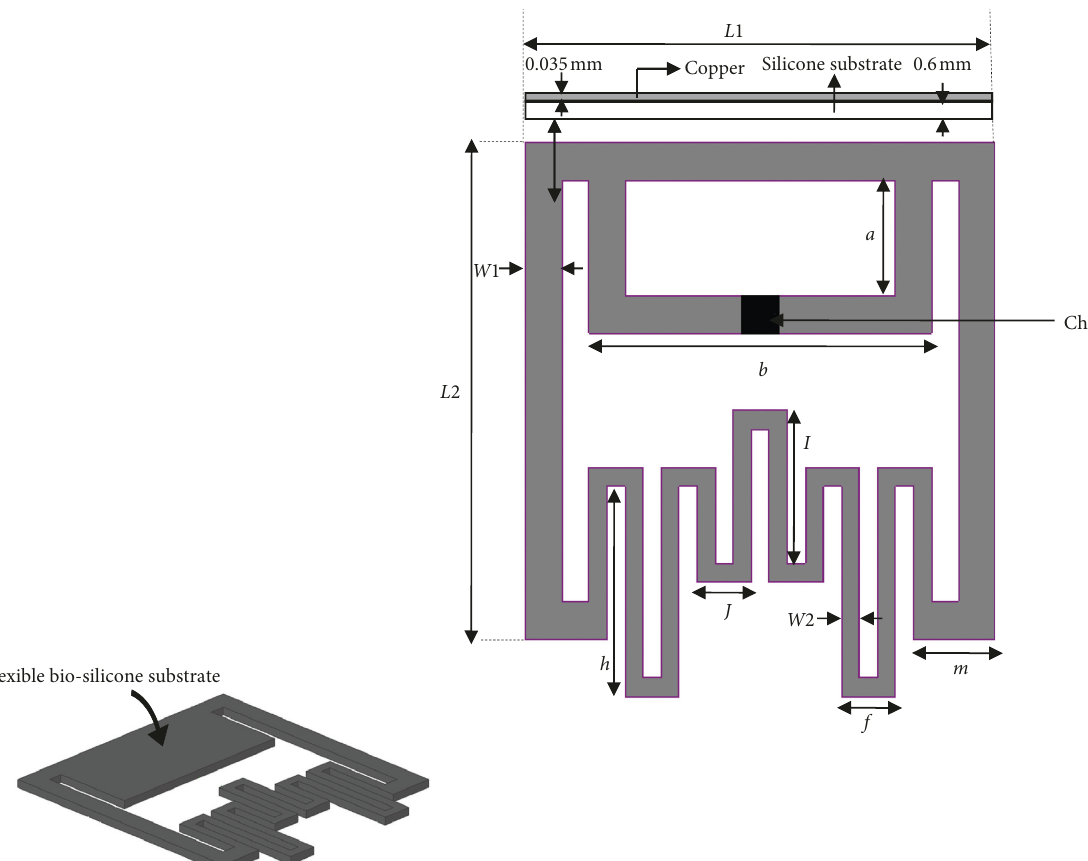
Figure 2: Geometrical design of dual loop tag with meandered line in the horizontal direction.